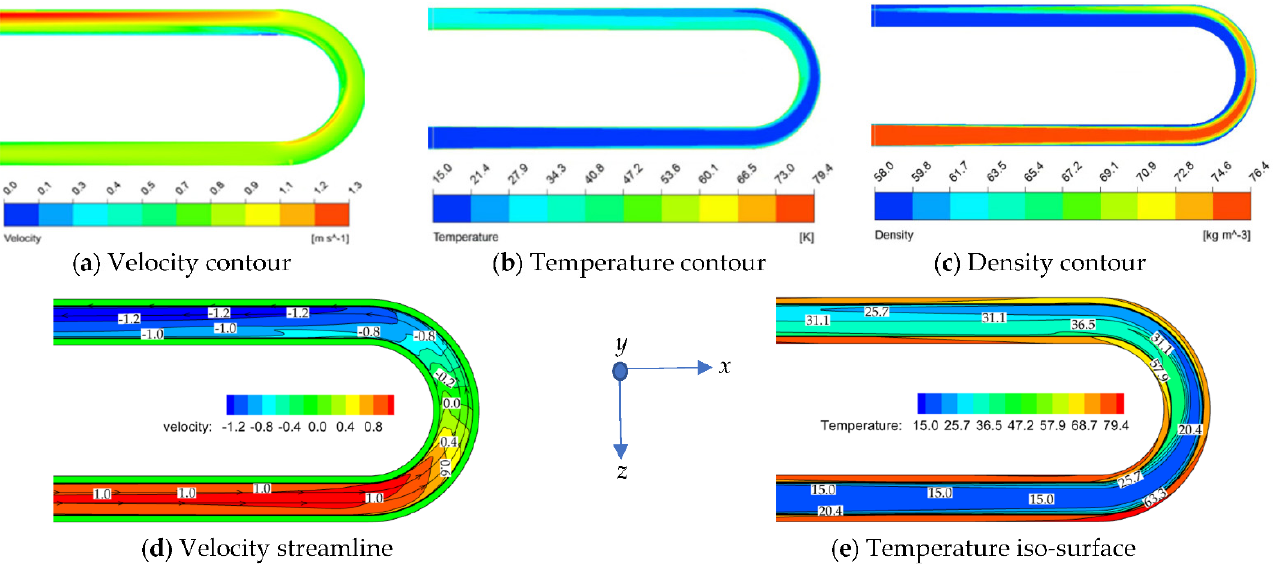
Figure 6. Velocity, temperature and density contours of xoy plane in U-type tube heating section.